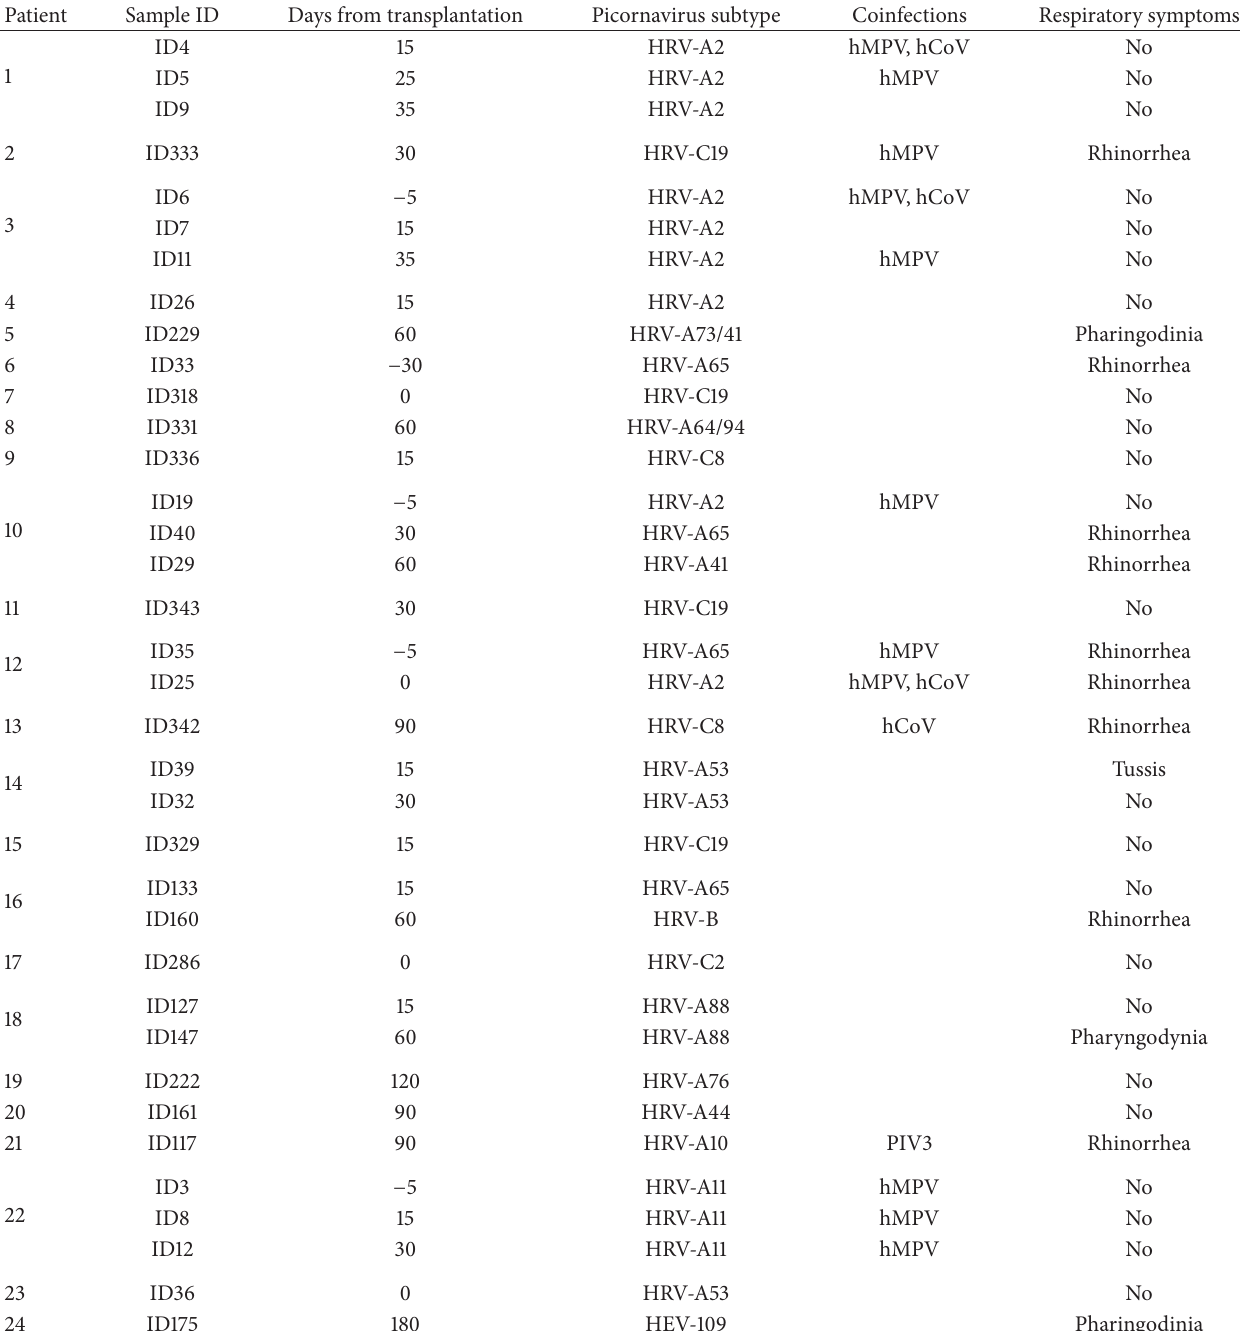
Table 1: Picornavirus positive samples. Samples’ ID (as shown in the phylogenetic tree) and time of collection are shown. Result of phylogenetic subtyping, coinfections, and respiratory symptoms are also